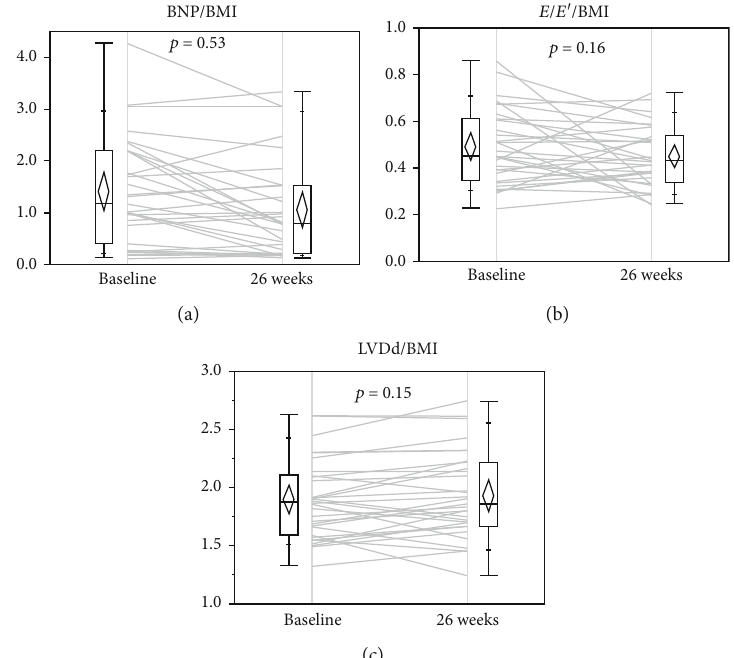
Figure 4: Changes in clinical parameters adjusted by BMI at baseline and 26 weeks after liraglutide introduction. Changes in (a) BNP, (b) E / E ′ , and (c) LVDd adjusted by BMI in the subjects. BNP: B-type natriuretic peptide; BMI: body mass index; E / E ′ : E wave to E ′ ratio on tissue Doppler echocardiography; LVDd: left ventricular diastolic diameter.